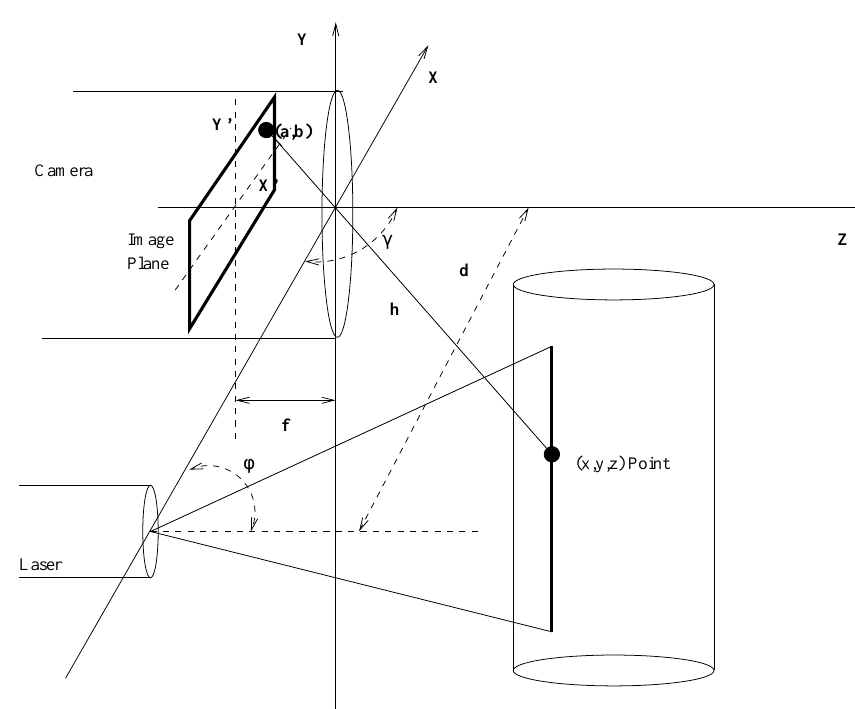
Figure 3. Triangulation